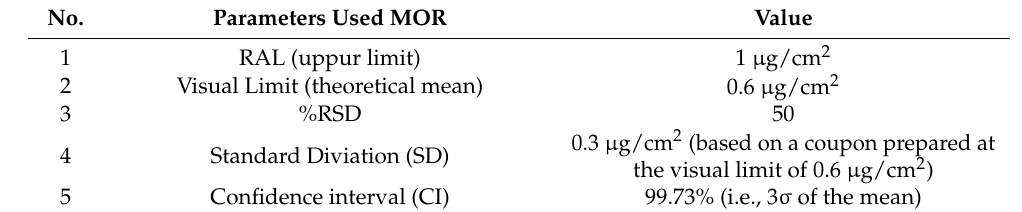
Table 1. Parameters used to calculate the MOE.